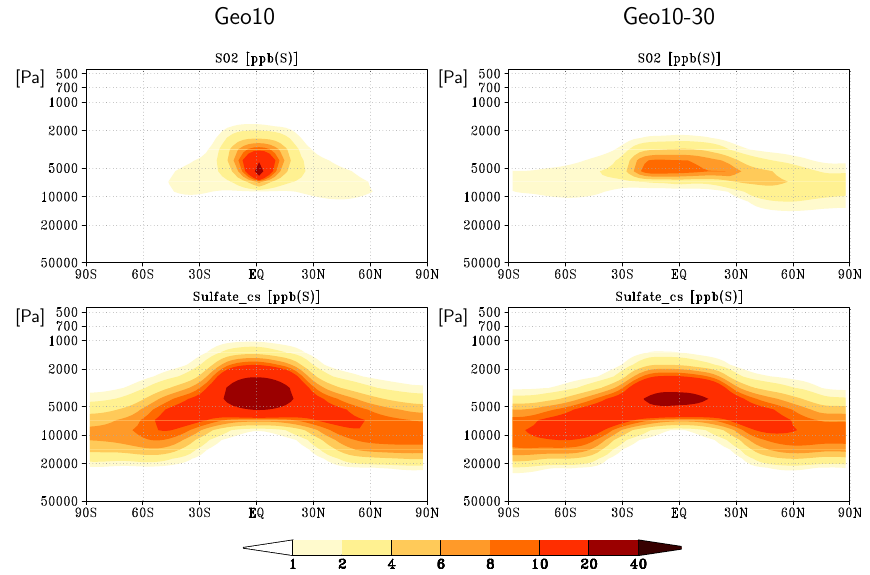
Figure 6. Zonally and annually averaged SO 2 (top) and sulfate coarse mode (bottom) concentration for Geo10 (left) and Geo10-30 (right) experiments with injection rates of 10Tg ( S ) yr − 1